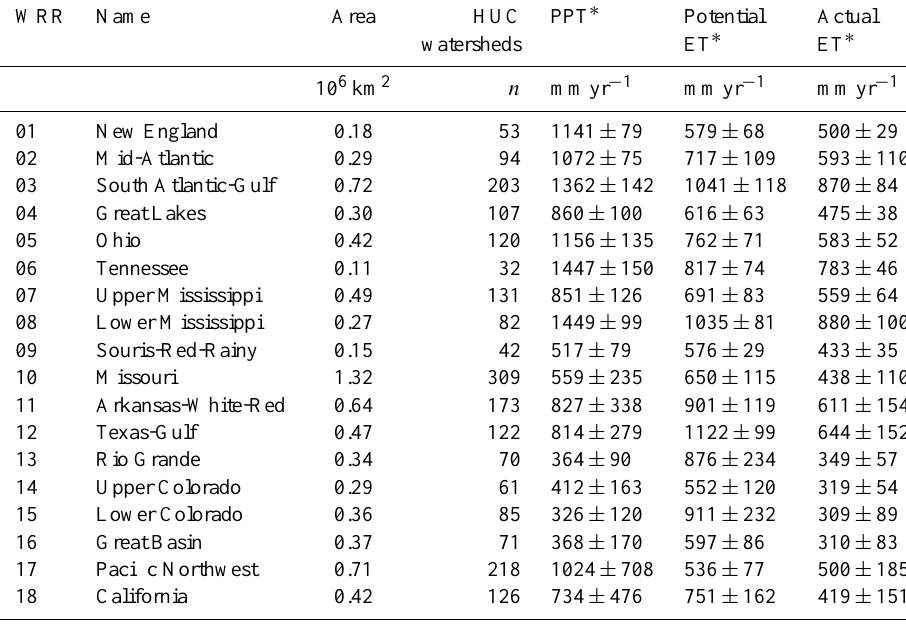
Table 1. Summary of Water Resource Regions (WRR) of the conterminous US. WRR Name